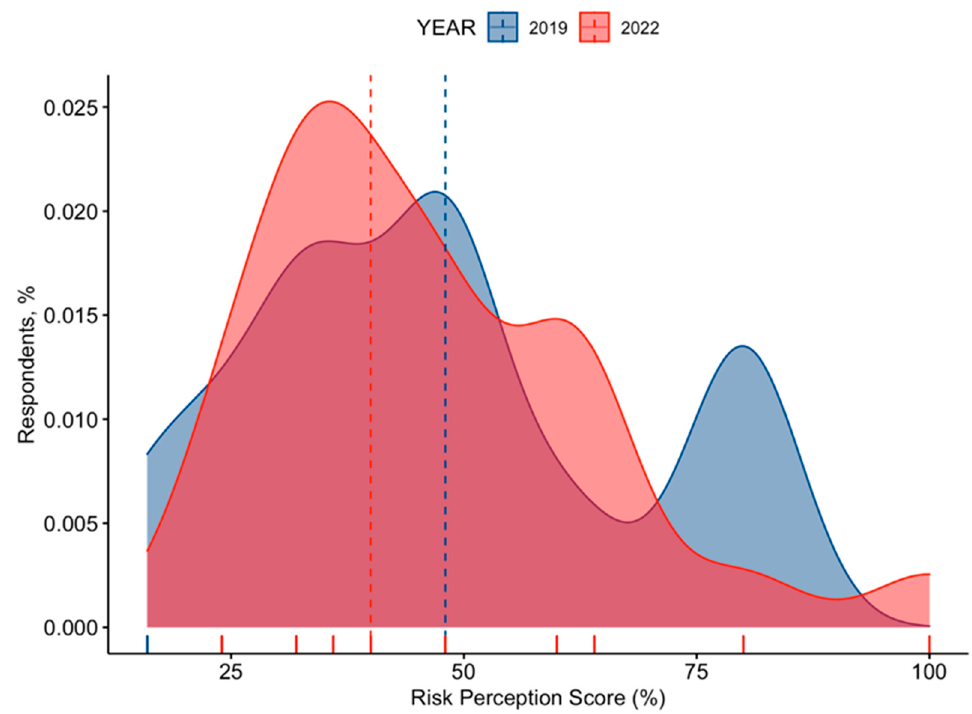
Figure 3. Risk Perception Score (RPS) on Travelers’ Diarrhea in 371 Italian occupational physicians participating in the survey, broken down by year of recruitment (i.e., 2019 vs. 2022). RPS was substantially skewed (D’Agostino–Pearson’s normality test K2 = 21.9, p -value < 0.001). Dotted lines represent median value (actual range: 16 to 100).